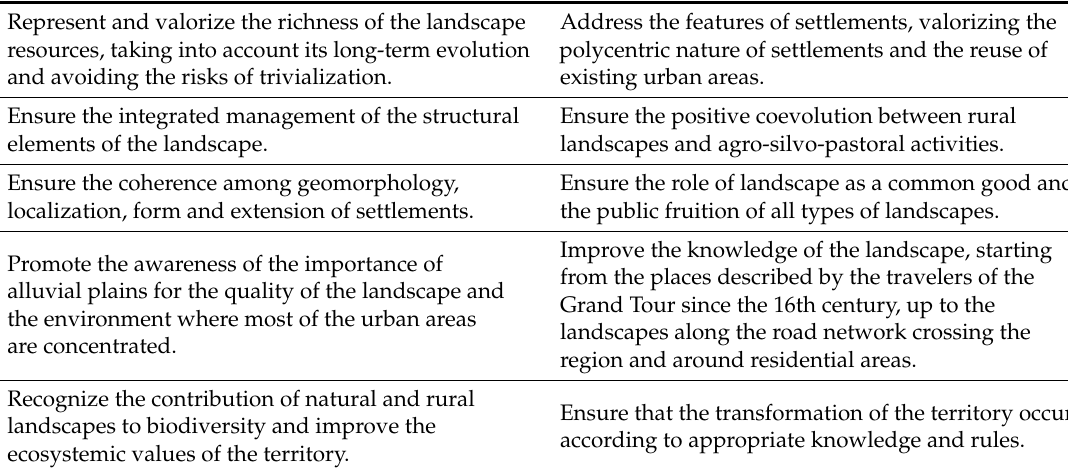
Table 1. The specific objectives of the landscape plan of